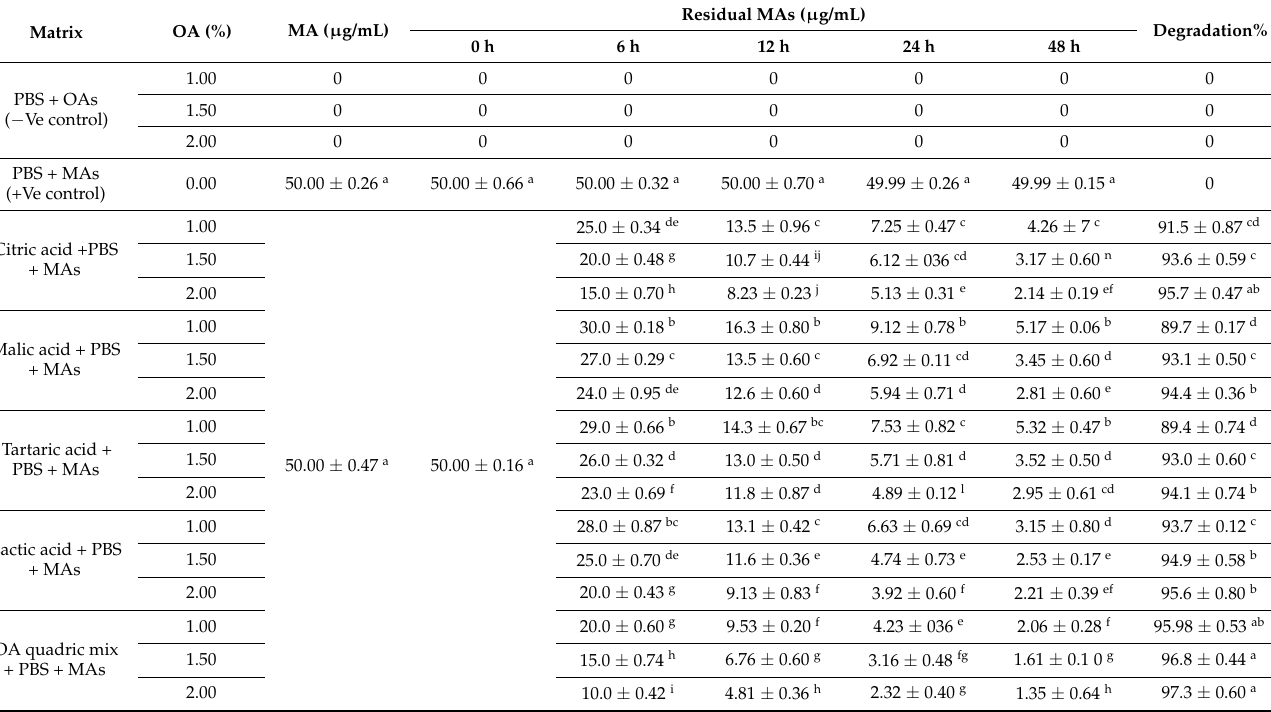
Table 1. Mycolic acid degradation efficiency by organic acids in PBS